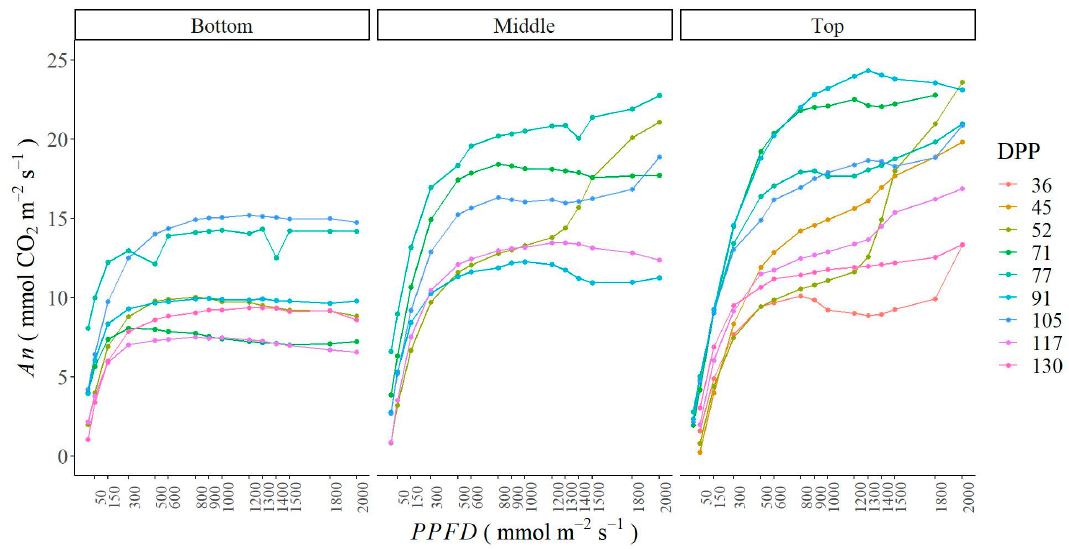
Figure 4. Measured response of net photosynthetic rate (An) for potato ( Solanum Tuberosum L. Var. Diacol capiro) to photosynthetic photon flux density (PPFD) at different days post planting (DPP) on the bottommost shaded leaves ( left ), middle leaves ( center ), and the topmost unshaded leaves ( rigth ) of potatoes ( Solanum Tuberosum L. Var. Diacol capiro).